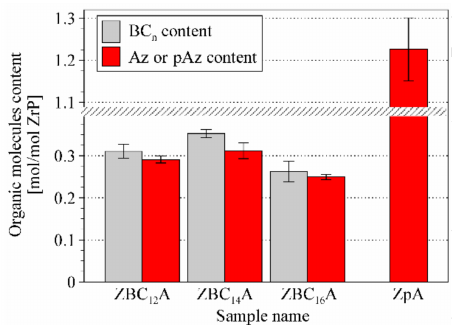
Figure 3. Molar content of organic molecules in the ZrP